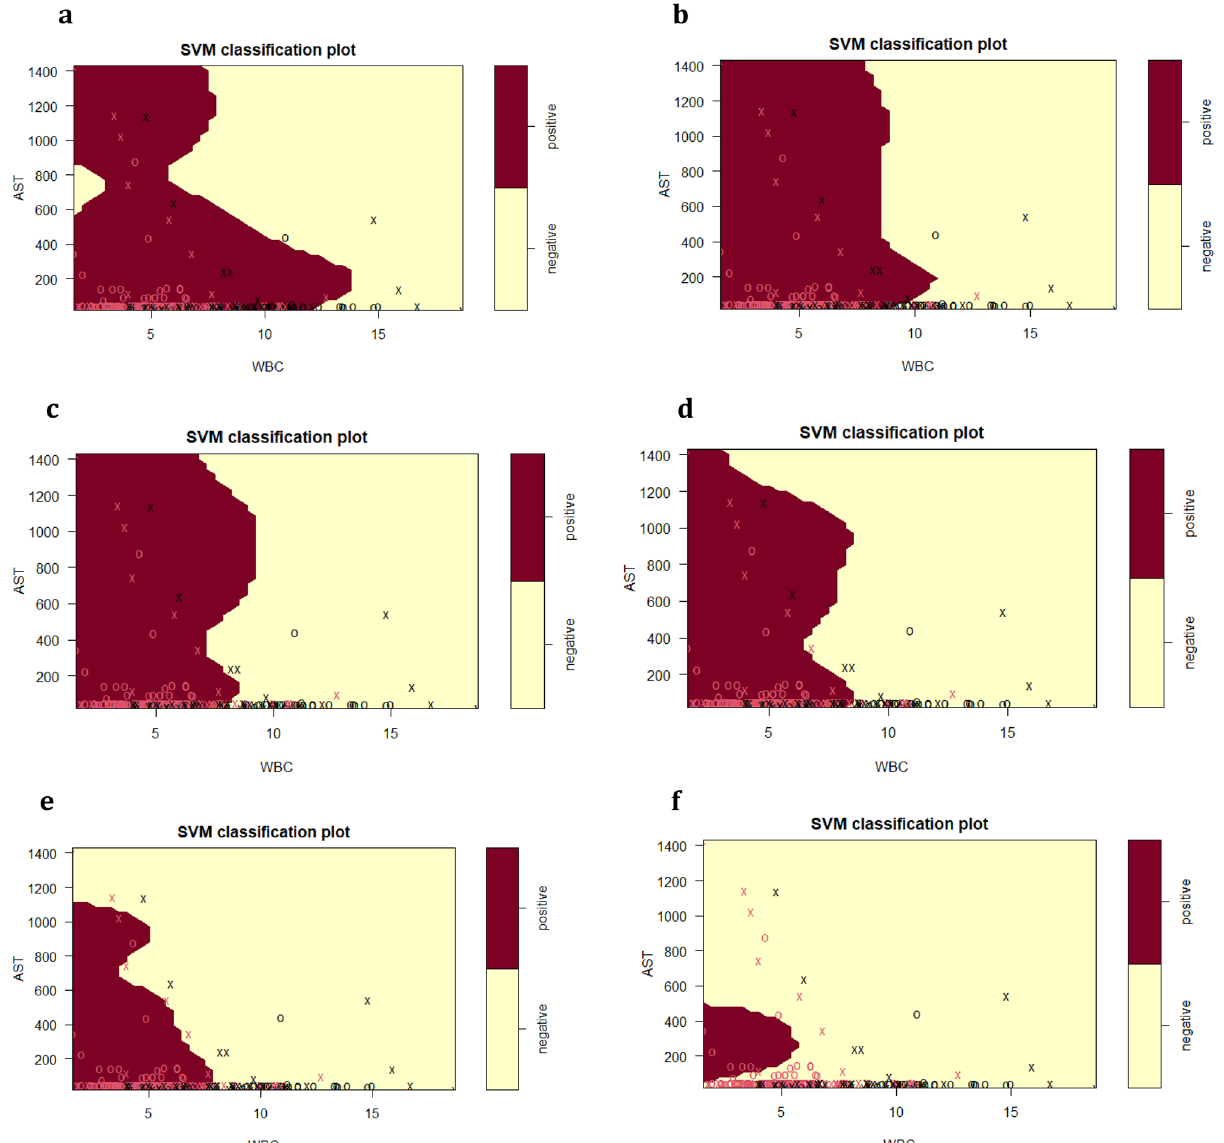
Figure 5. SVM plots describing the interaction of serum AST, WBC and patient age at the time of HBV testing for the classification of HBsAg positive versus HBsAg negative results, as previously detected by specific HBsAg immunoassay. ( a ) Age = 15 years; ( b ) Age = 25 years; ( c ) Age = 35 years; ( d ) Age = 45 years ( e ) Age = 55 ( f ) Age =